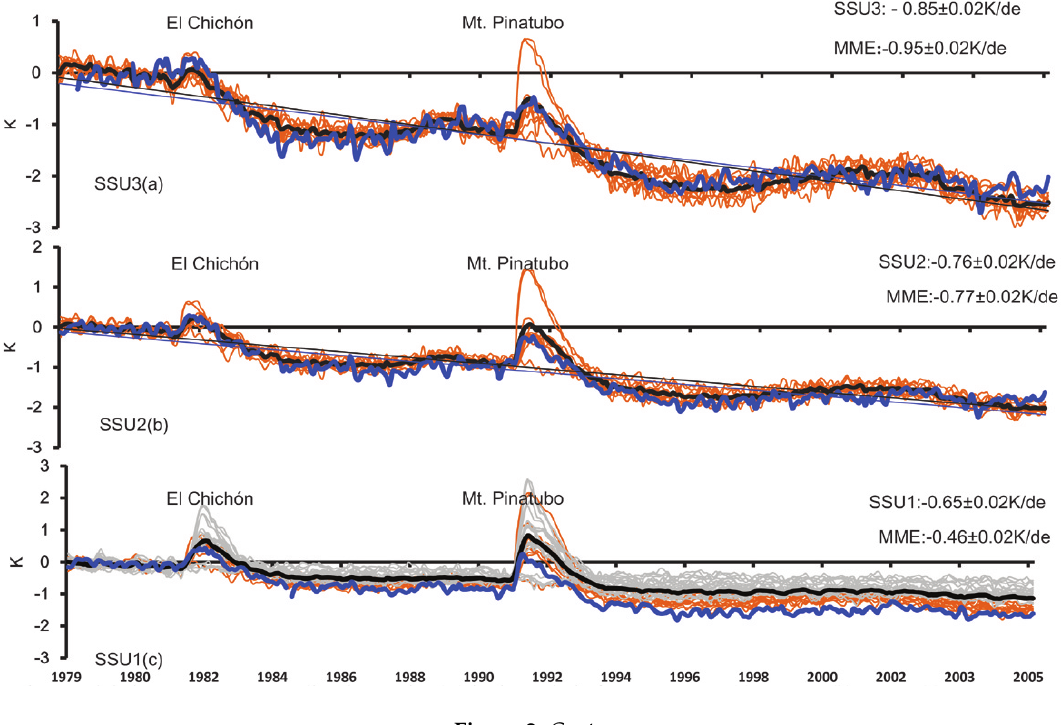
Figure 2. Cont. Figure 2.